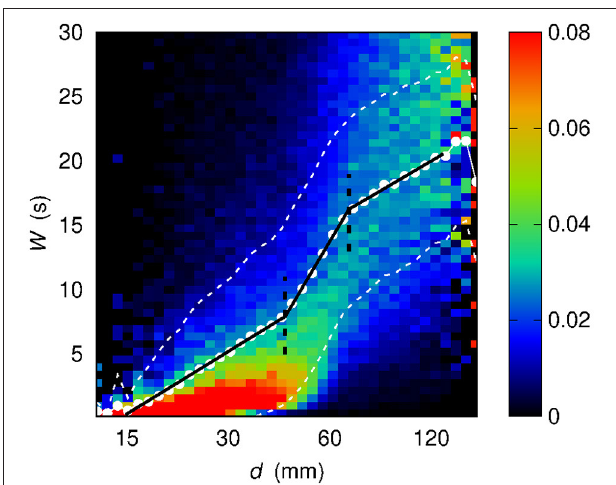
FIGURE 7 | Conditional sample distribution f ( W | log d ) of W given log d (the d axis is in log scale) obtained by partitioning both the log d range and the W range in 50 bins. White dots show the average value W of W given log d . White dashed lines bound the 68% confidence region for W , namely the region within 1 σ from the average W . Black solid lines stem from a best-fit procedure (see section 3) concerning a piecewise-linear relationship between W and log d . Black dashed lines correspond to the log d values at which the slope of the piecewise-linear relationship changes.